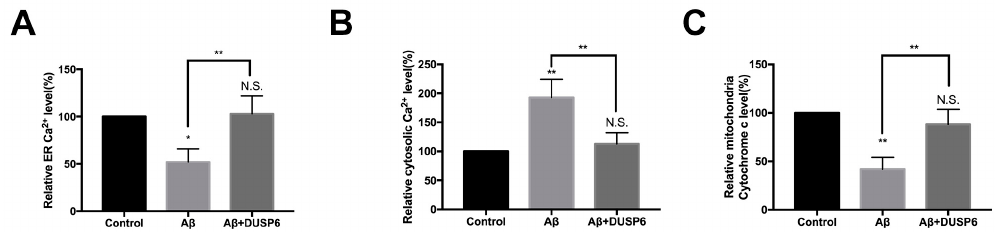
Figure 4. DUSP6 reversed A β -induced effect on ER Ca 2+ level and mitochondrial cytochrome c homeostasis in NSCs. NSCs were either pre-transfected with DUSP6 overexpression plasmid or not transfected. Both groups were treated with 5 μ M A β 25–35 for 24 h. ( A ) Endoplasmic reticulum (ER) calcium was detected by fluorescent probe Fura-2/AM; ( B ) Cytosolic Ca 2+ content in NSCs was measured with Indo-1/AM. ( C ) An enzyme-linked immunosorbent assay (ELISA) kit was adopted for the assay of cytochrome c in NSCs’ mitochondria. N.S.: p > 0.05, *: p < 0.05, **: p < 0.01 vs. control. **: p < 0.01 vs. A β -treated group. n = 3.